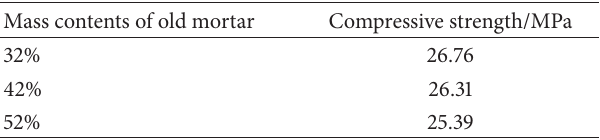
Table4:CompressivestrengthsofRACwithdifferentmasscontents of old mortar.